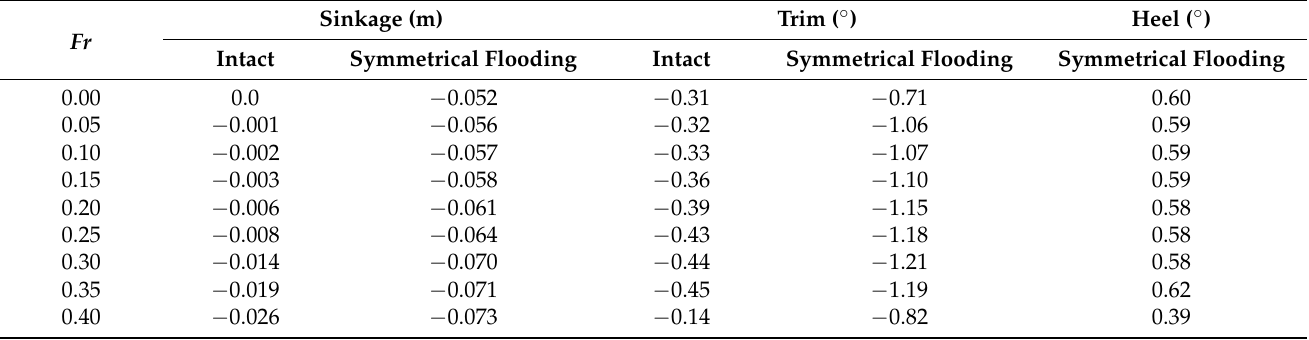
Table 9. The comparison of attitudes in intact and symmetrical flooding cases at different for- ward